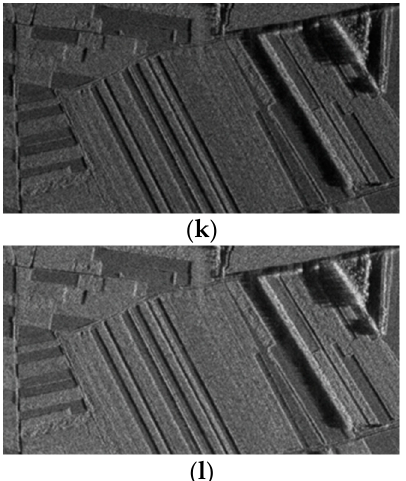
Figure 8. ( a ) Result of single-channel imaging: ( b , c ) results before and after calibration of 10-channel DBF-SAR; ( d – f ) The house; ( g – i ) The ground calibration points; and ( j – l ) the farmland.